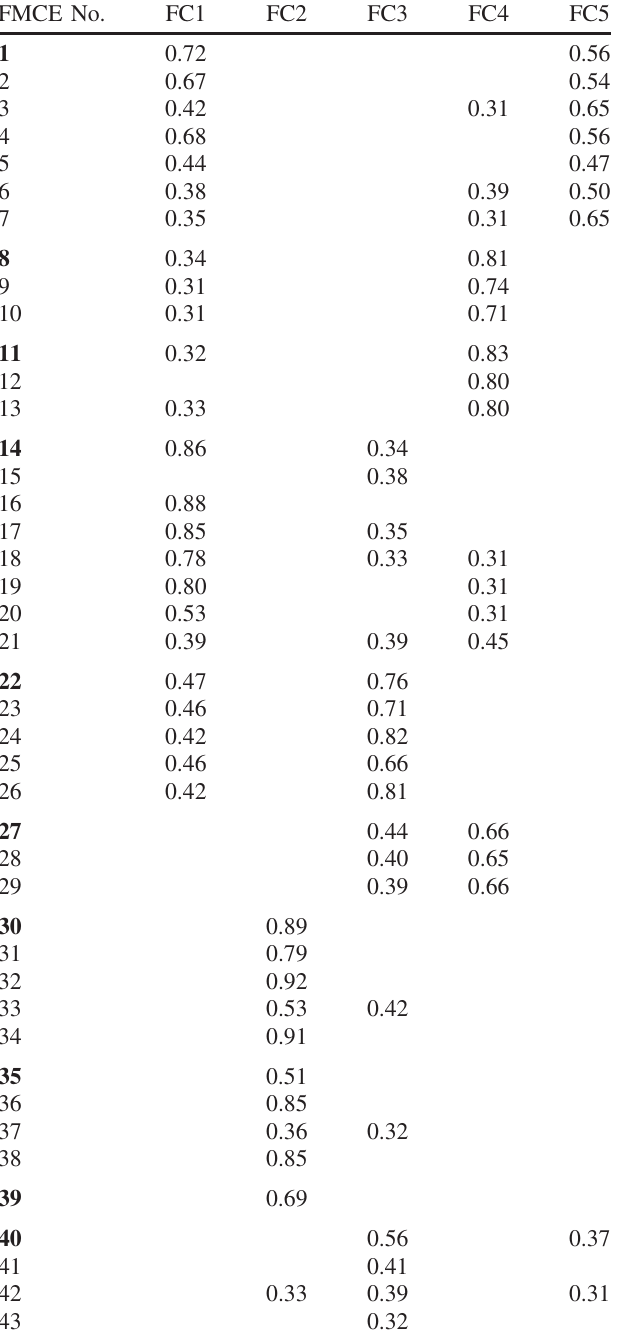
TABLE II. Factor loadings for the 5-factor model using exploratory factor analysis with Multidimensional IRT (varimax rotation). The bolded item numbers represent the start of item blocks which are also separated by horizontal lines. Loadings of magnitude greater than 0.3 are